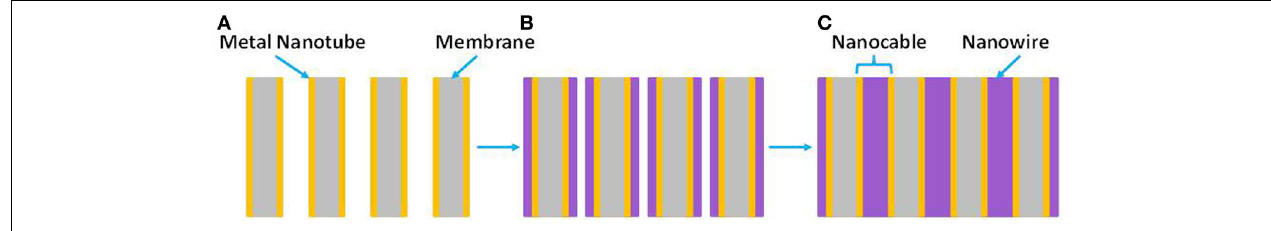
FIGURE 5 | (A) Metal-nanotube membrane formed by electroless deposition of metal nanotubes inside the PCTE membrane. (B) Electrochemical deposition radially fills in the nanopores (the arrows show growth direction). (C) Nanocables obtained inside nanoporous PCTE